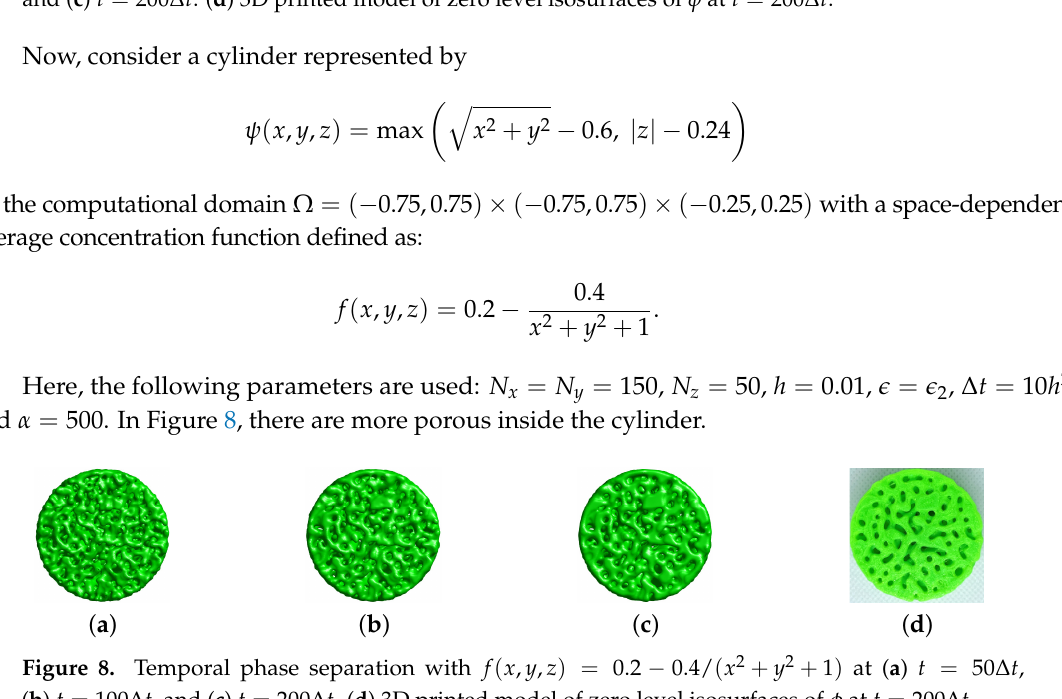
Figure 7. Zero level isosurfaces of φ with f ( x , y , z ) = − 0.15 − 0.25 ( z + 0.5 ) 2 at ( a ) t = 20 ∆ t , ( b ) t = 50 ∆ t , and ( c ) t = 200 ∆ t . ( d ) 3D printed model of zero level isosurfaces of φ at t = 200 ∆ t .